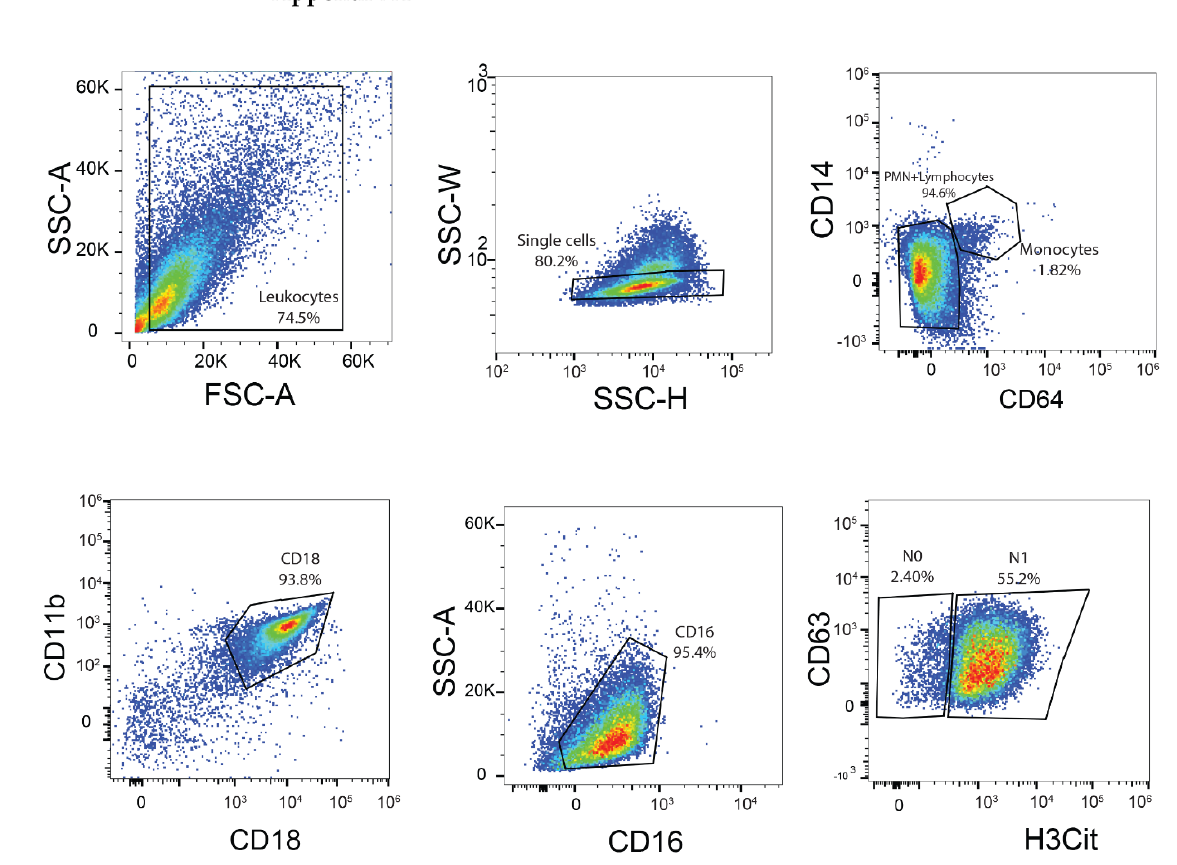
Figure A1. Example of the gating system used for a single patient’s oral rinse sample used in the FlowJo software to measure the geometric MFI for each of the oPMN markers. Gating was performed as follows: Doublets were excluded by SSC-W × SSC-H (side scatter: width × height). To filter out oral macrophages and monocytes, CD14 + area and CD64 + area population were used. the remained population are put on CD11b + area and CD18 + area for reaching PMNs only. To ensure that 100% oral PMNs are captured, a CD16 + area is utilized. The last gating scheme, CD63 + area and H3Cit + area were used to distinguish between primed oPMNs (N1) and regular oPMNs (N0). Table A1. Absolute oPMN counts and descriptive statistics across the four time points.